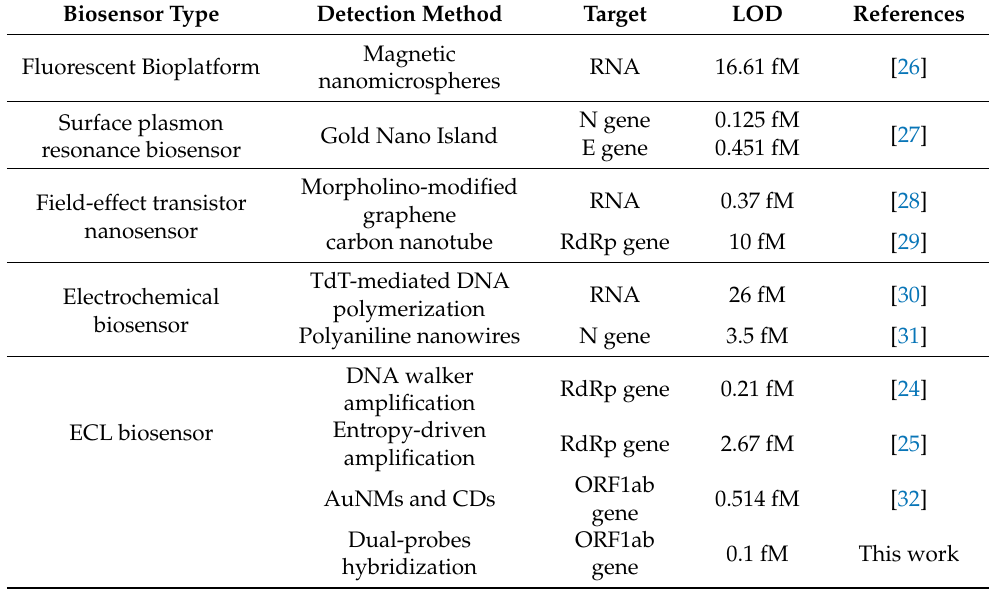
Table 4. Different types of biosensors detect